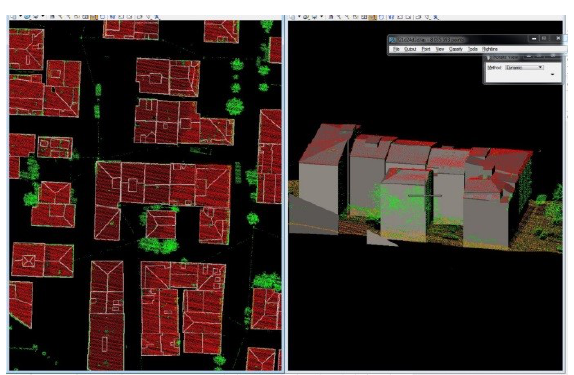
Figure 10: Complex (mosques) objects via manual technique